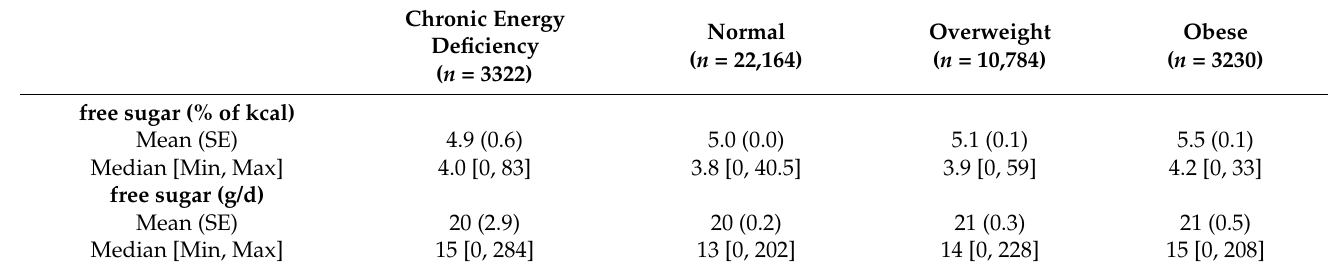
Table 8. Intakes of free sugars by BMI status (age range 19+).